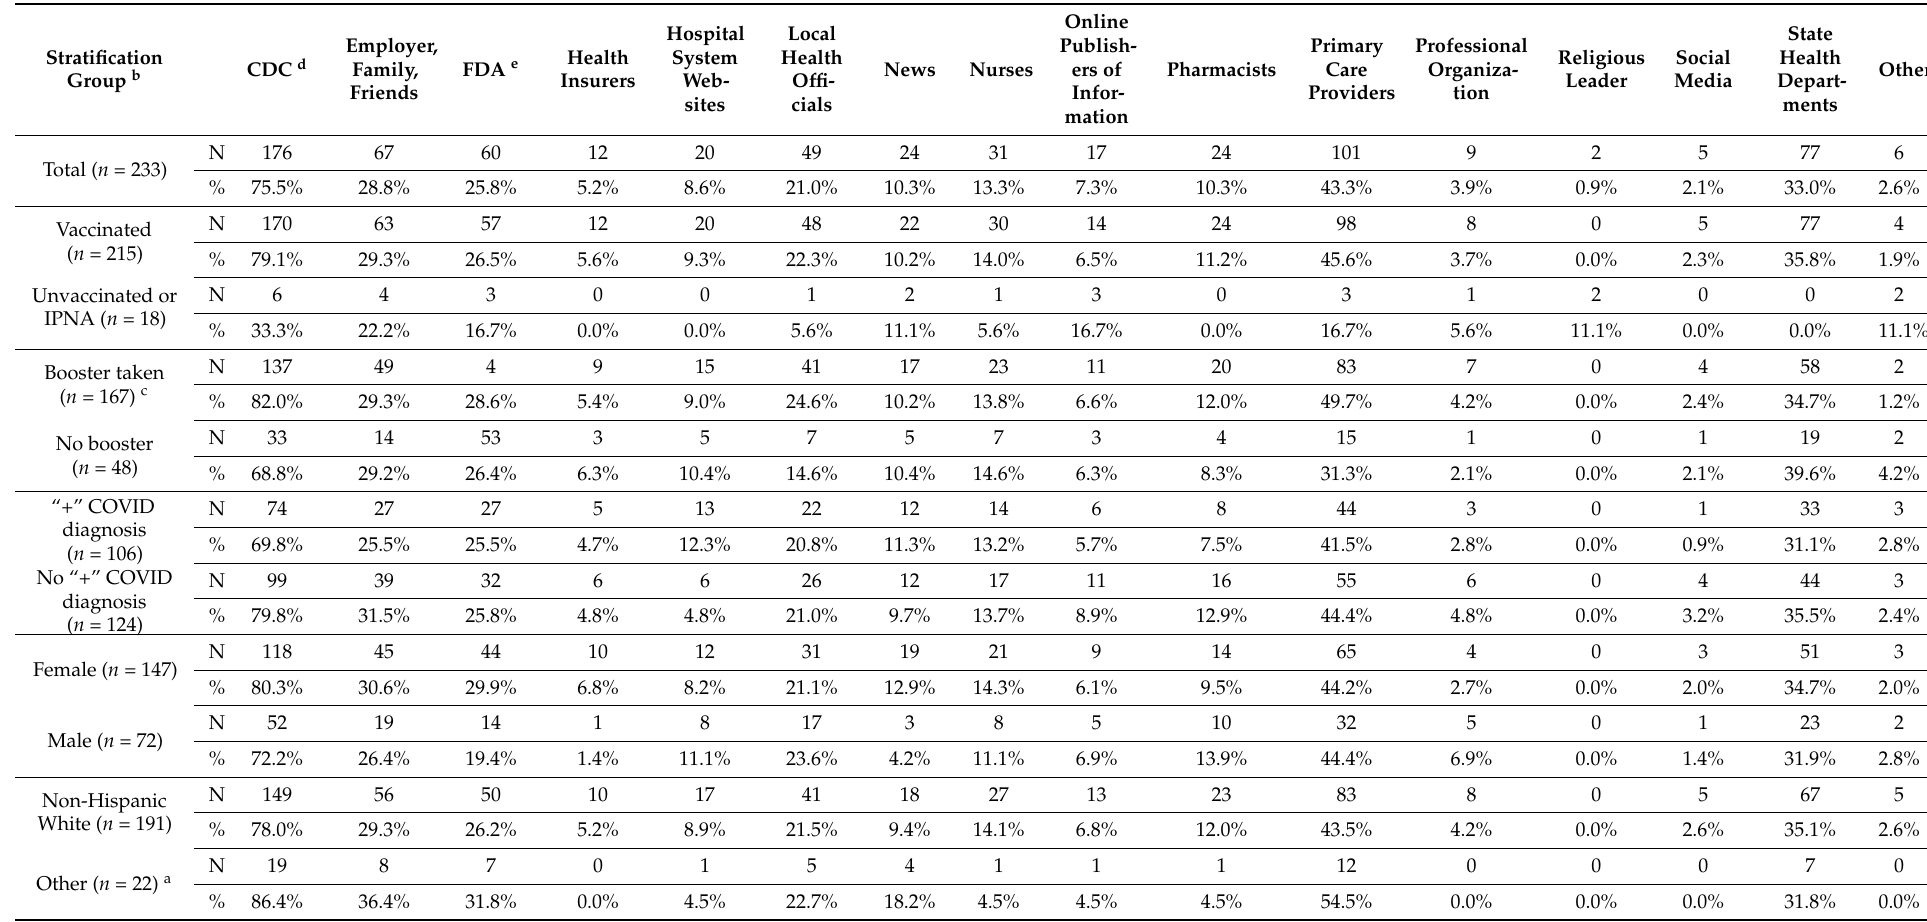
Table 2. Identified trusted sources of information about the COVID-19 vaccine by stratification among the NJ secondary or high school teachers. Select your top 3 most trusted sources of information about the COVID-19